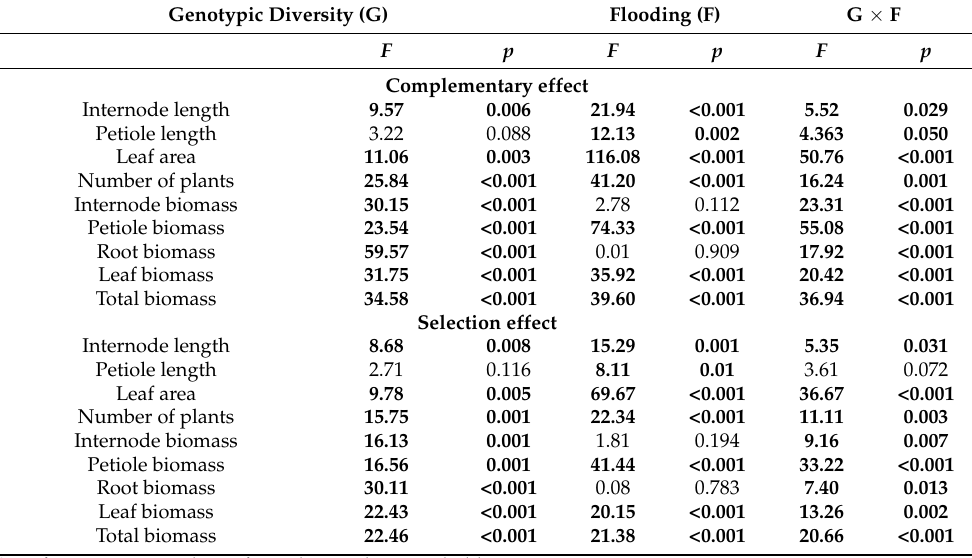
Table 2. ANOVAs for effects of genotypic diversity and flooding on complementarity effect and selection effect of growth traits of H. vulgaris.